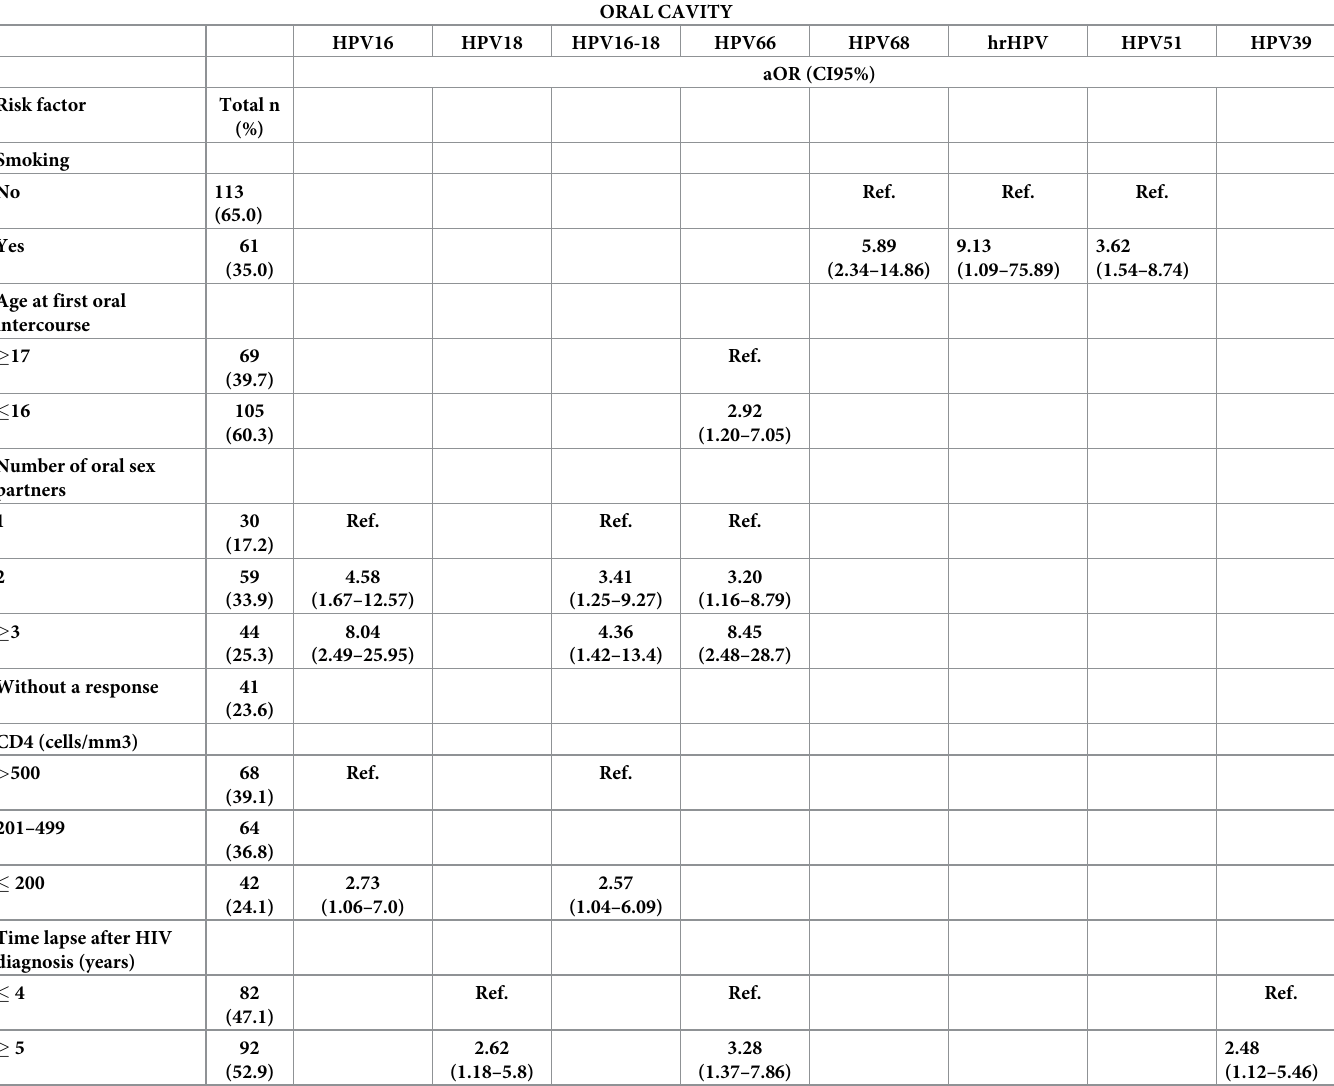
Table 2. Risk of hrHPV infections in the oral cavity associated with sociodemographic and clinical factors (OR = adjusted odds ratio calculated by binary logistic regression; CI 95% = confidence interval at